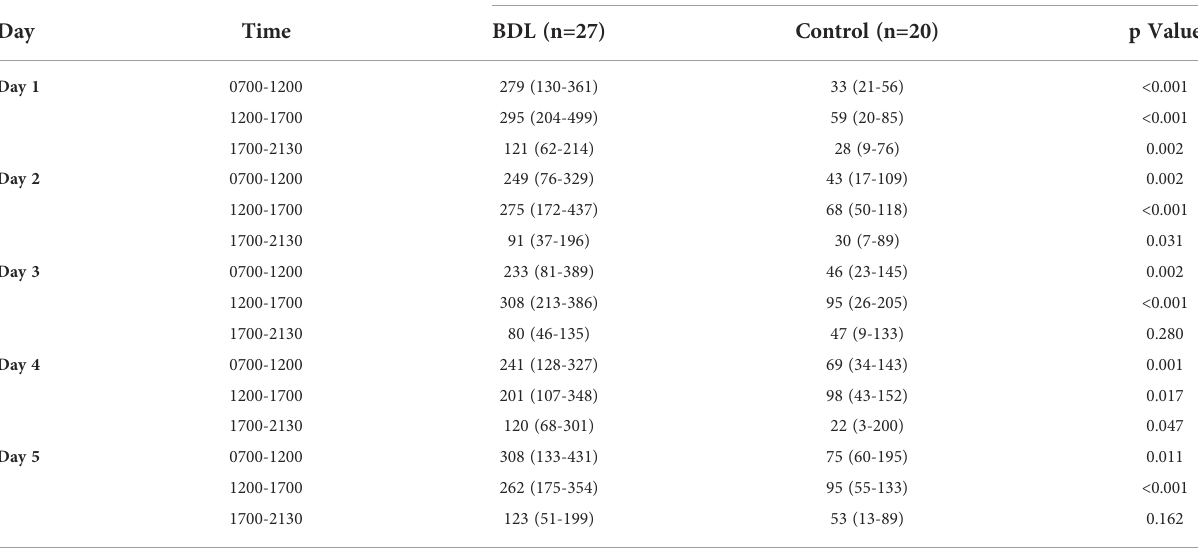
Illuminance, lux